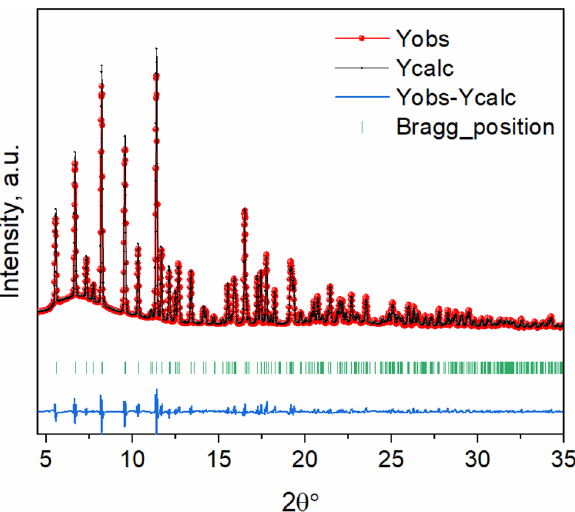
Figure 1. Rietveld refinement of the synchrotron XRD pattern of as-synthesized LiCo 0.5 Fe 0.5 PO 4